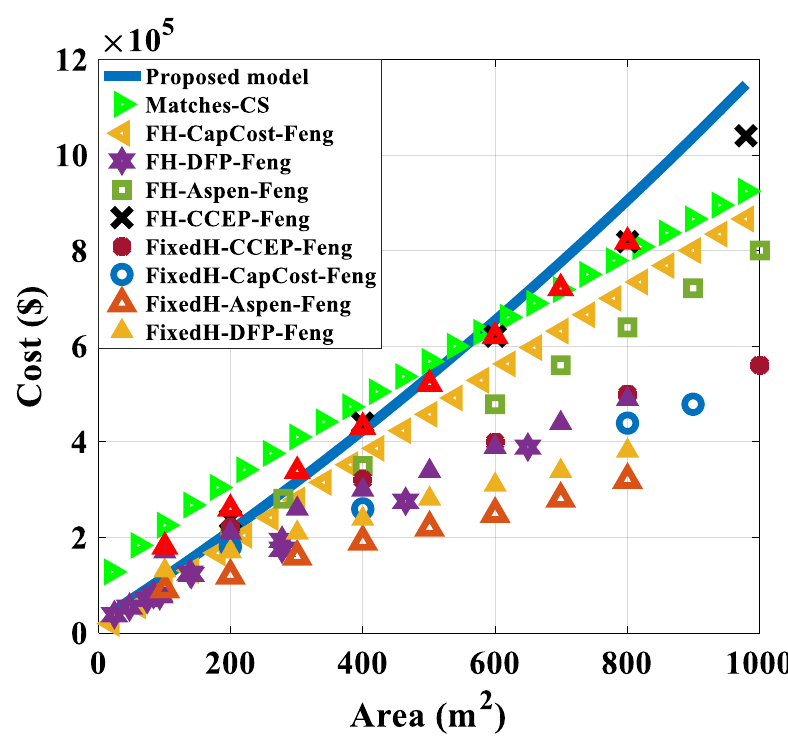
Figure 10. Shell-and-tube heat exchanger cost against the area [28,52].